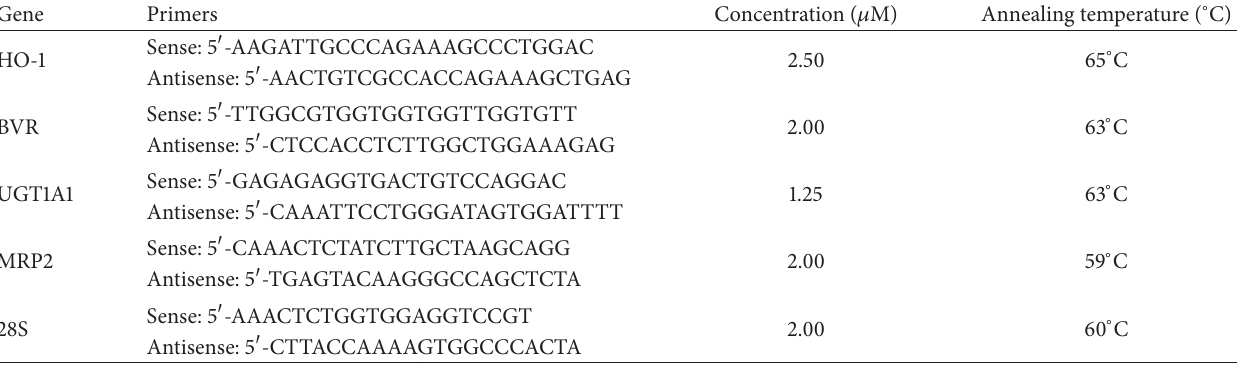
Table 1: Primers and conditions used for real-time RT-PCR experiments.